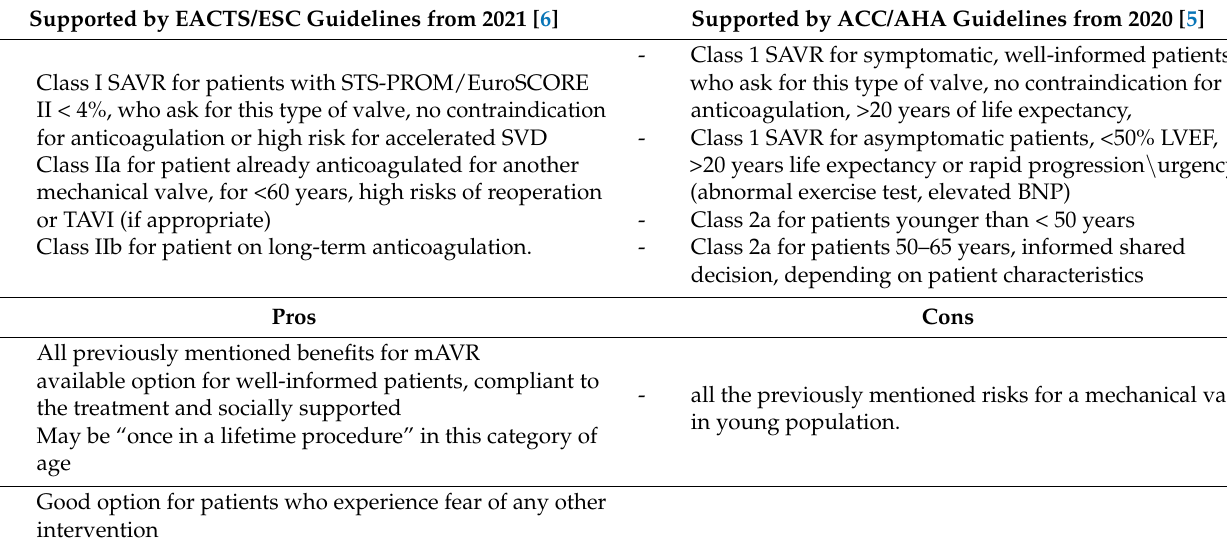
Table 4. Decision Making Algorithm. m-AVR for middle-aged patients.